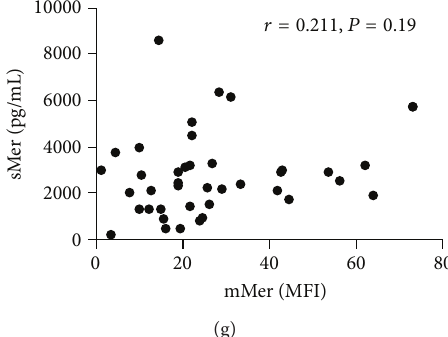
Figure 2: Example of quantification of blood CD14+ monocytes/macrophages and CD14+CD16+ macrophage subset. Membrane MerTK and CD163 expression were measured by flow cytometry as mean fluorescence intensity (MFI). Following monoclonal anti-human Abs were used for detection of FITC-conjugated anti-CD14 Ab, APC-conjugated anti-CD163 Ab, and PE-conjugated MerTK Ab. (a) Cell distribution based on the forward-scatter and side-scatter; the monocytes/macrophages population is identified and gated accordingly. The fraction of monocytes/macrophages positive for CD14 is identified and gated. (b) Histogram showing the MFI of CD14+ monocytes/macrophages positive for MerTK in IgG1 isotype (Purple line), healthy controls (Heavy blue line), and SLE patients (Light green line). mMer expression on CD14+ monocytes/macrophages subset was significantly elevated in patients with SLE compared with healthy controls. (c) CD163 expression on the surface of CD14+ monocytes/macrophages shown by histogram was different between SLE patients (Light blue line) and healthy controls (Red line). Bar showed the more expansion of CD163 expression on CD14+ monocytes/macrophages subset in SLE patients than healthy controls. (d) Correlation between CD163 and mMer expression on CD14+ cells. (e) Characterization of the monocytes/macrophages subsets in PBMC from healthy controls and patients with SLE. The dot plot represented the CD14 and CD16 expression on monocytes/macrophages. Percentages of CD14+CD16+subset among total monocytes/macrophages were significantly reduced in SLE patients. Circles and squares in solid represented CD14+CD16+ cell frequencies of healthy controls and SLE patients, respectively. CD14+CD16+ monocytes/macrophages subset had elevated mMer expression in patients with SLE in comparison with healthy controls. (f) Comparison about sMer levels in plasma between healthy controls and SLE patients. (g) Correlation between sMer in plasma and mMer on CD14+ cells. The mean ± SD of MFI was shown by bars represented for SLE patients in solid and healthy controls in blank. Horizontal lines above bars showed difference and vertical lines showed standard errors. FSC: forward scatter; SSC: side scatter; mMer: membrane Mer tyrosine kinase; FITC: fluorescein isothiocyanate; APC: allophycocyanin; PE: phycoerythrin; PBMC: peripheral blood mononuclear cell. ∗∗ 𝑃 < 0.001 , ∗∗∗ 𝑃 < 0.0001 .